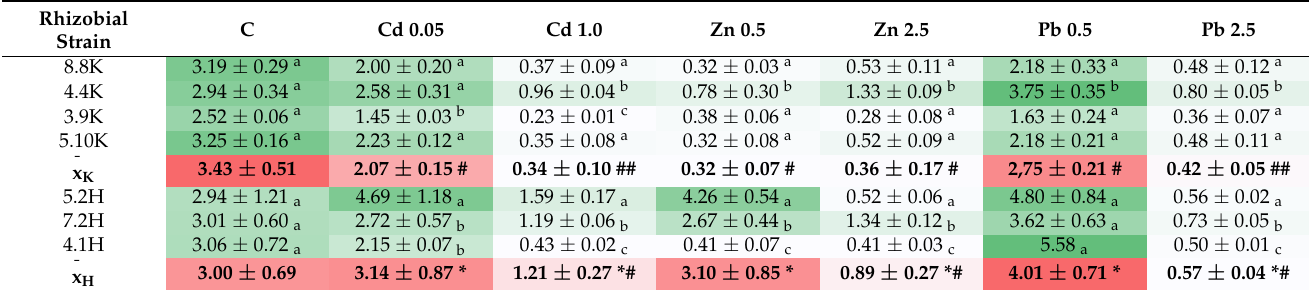
Table 3. Living-to-dead cell ratio (L/D) in biofilms formed by R . leguminosarum bv. trifolii strains isolated from root nodules of T. repens growing on non-polluted reference grassland BolesTable 100. year-old Zn–Pb waste heap Bolesław (H) non-exposed (C) and exposed to 0.05 mM (Cd 0.05) and 1.0 mM (Cd 1.0), 0.5 mM (Zn 0.5) and 2.5 mM (Zn 2.5), and 0.5 mM (Pb 0.5) and 2.5 mM (Pb